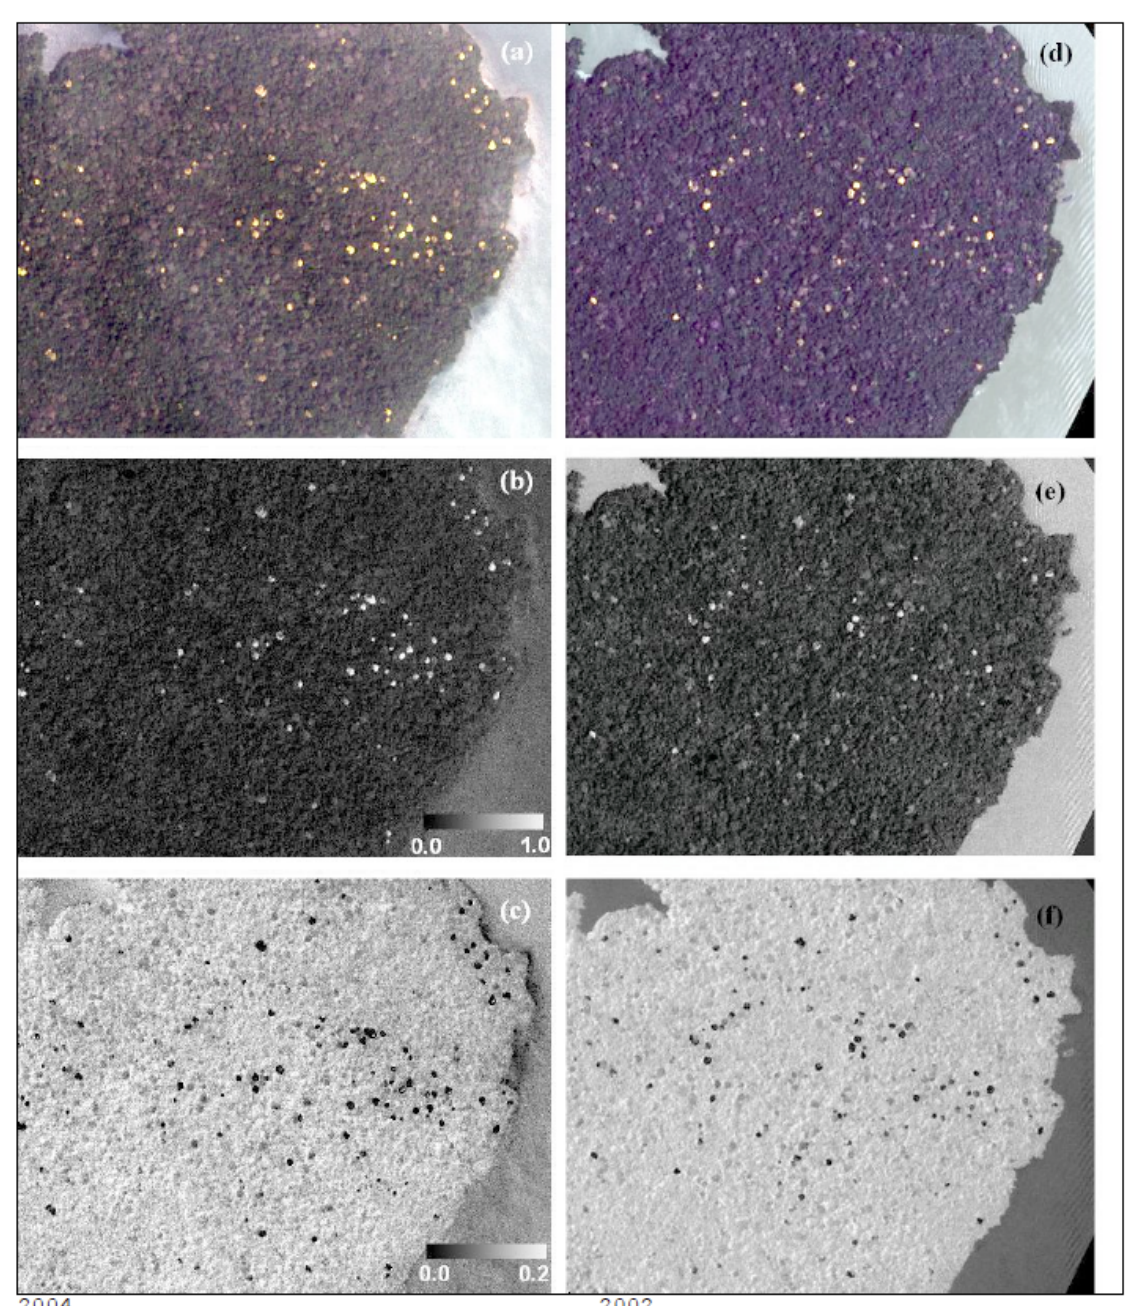
Figure 3. Selected area of Barro Colorado Island Quickbird satellite imagery (northwest region) of flowering T. guayacan acquired in (a) March 21st, 2004 and (d) April 29th, 2002. (b-e) Abundance map of T. guayacan estimated from the LSU algorithm. Scale bar represents the range of per-pixel fractional abundance. (c-f) Result from SAM algorithm for the same region. Scale bar represents the range of spectral angle (in radian) between the spectrum of each pixel and that of T.